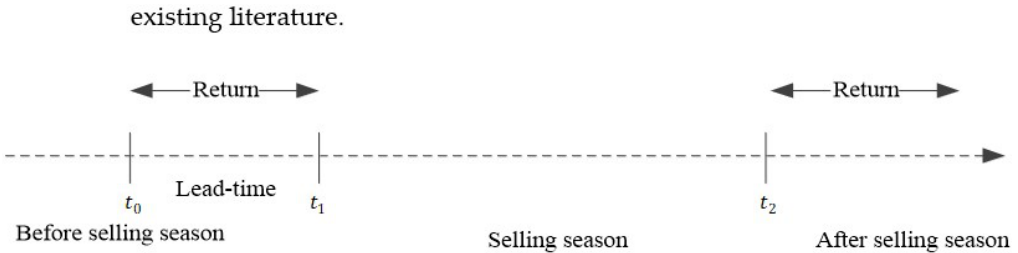
Figure 1. Products returned during different sales